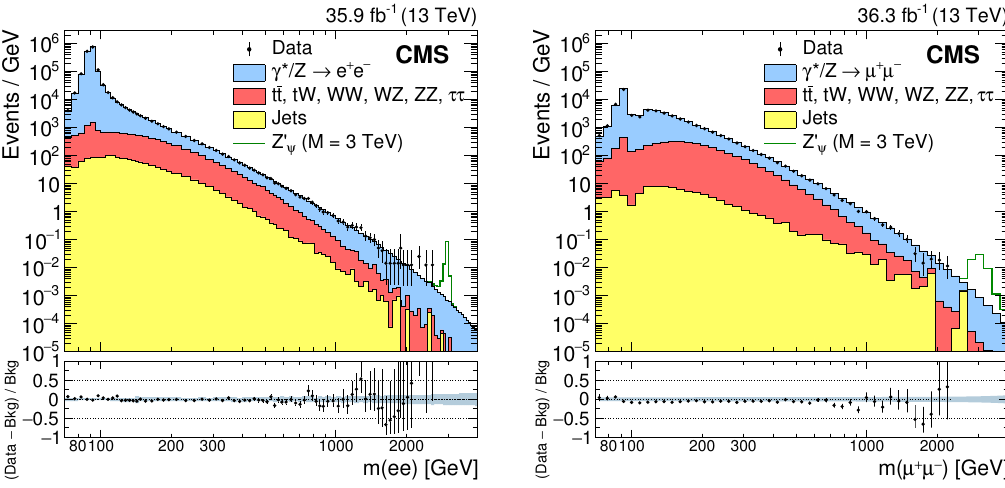
Figure 1 . The invariant mass spectra of dielectron (left) and dimuon (right) events. The points with error bars represent the observed yield. The histograms represent the expectations from the SM processes. The bins have equal width in logarithmic scale so that the width in GeV becomes larger with increasing mass. Example signal shapes for a narrow resonance with a mass of 3 TeV are shown by the stacked open histograms. The uncertainty bands in the ratio plots represent the systematic uncertainty in the background yields.